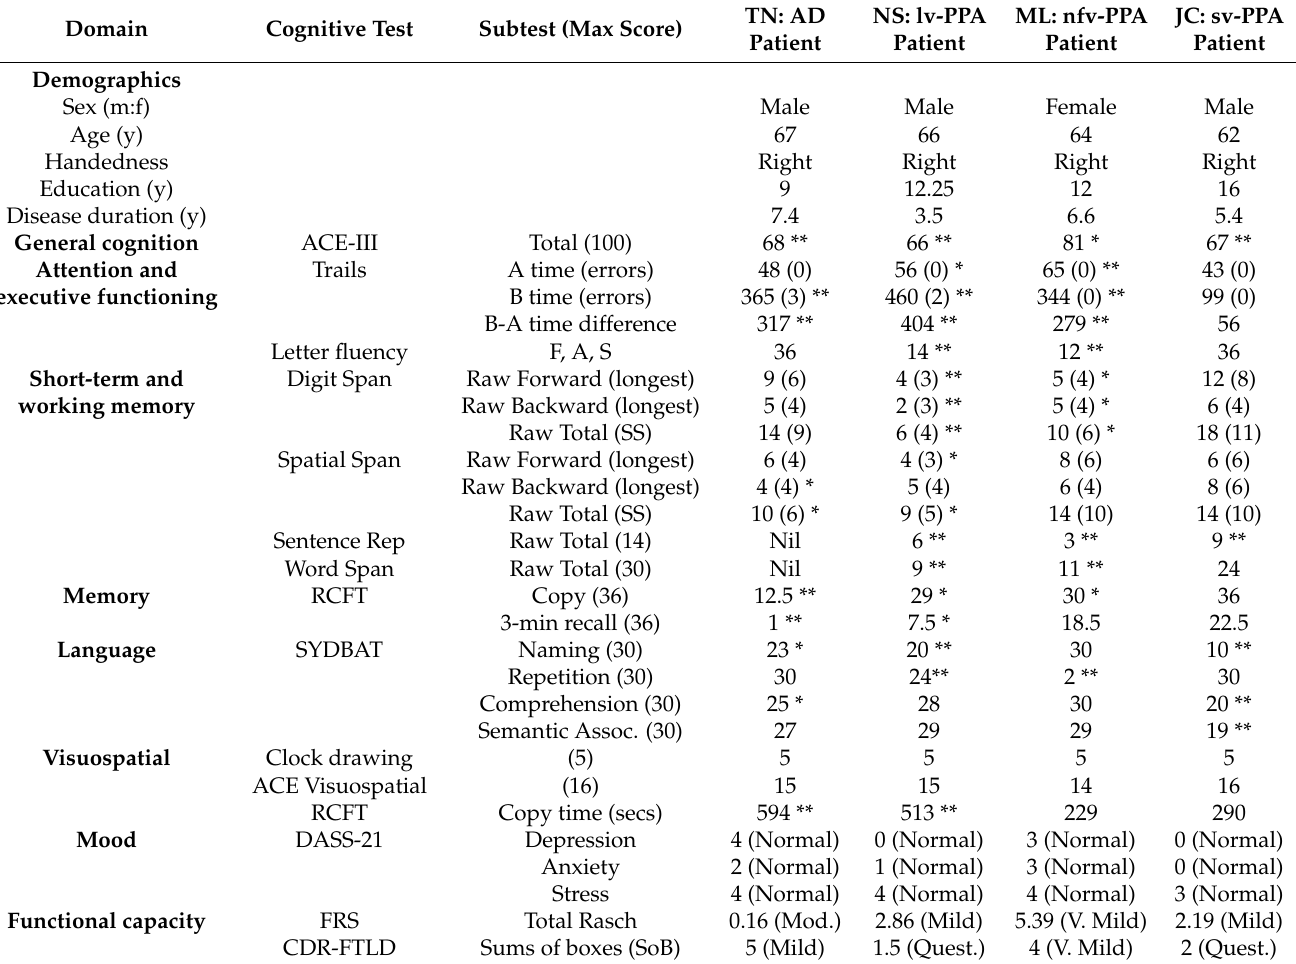
Table 1. Demographics and neuropsychological test